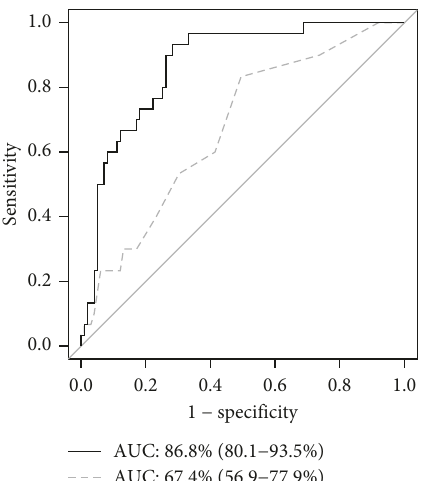
Figure 3: Receiver operating characteristic curves for IMT-Cmax and logistic regression model to predict mild NPDR. The area under the curve (AUC) of IMT-Cmax to predict mild NPDR was 0.67 (95% CI: 0.57–0.78; sensitivity: 83.3%; specificity: 50.5%; shown by the dotted grey line). The AUC for a logistic regression model was 0.87 (95% CI: 0.80–0.94; sensitivity: 93.3%; specificity: 71.7%; shown by the solid black line).